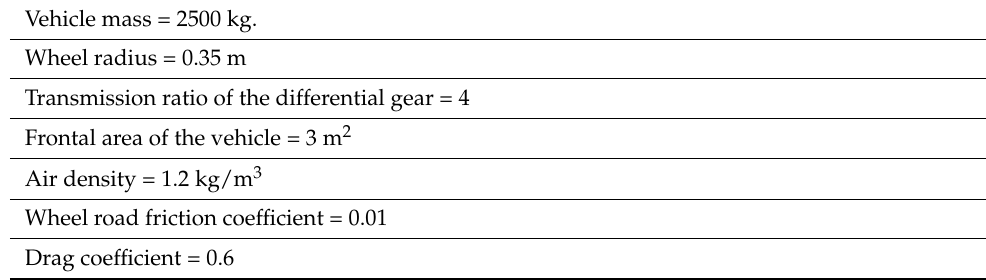
Table 2. Main data of the vehicle. Vehicle mass = 2500 kg. Wheel radius = 0.35 m Transmission ratio of the differential gear = 4 Frontal area of the vehicle = 3 m 2 Air density = 1.2 kg/m 3 Wheel road friction coefficient =